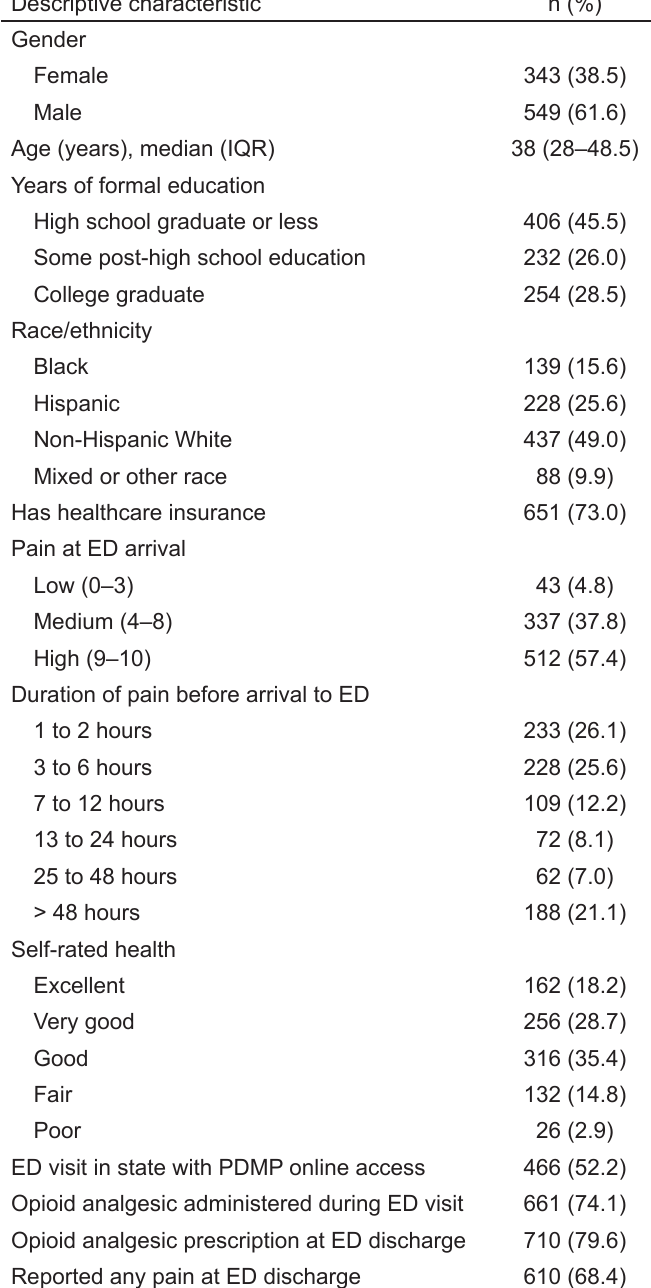
Table 1. Clinical and demographic characteristics of 892